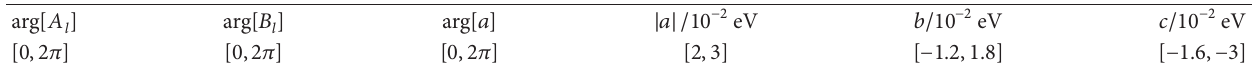
Figure 1: Predictions for mixing angles ( 𝜃 13 , 𝜃 12 , and 𝜃 23 ), Dirac CP violating phase 𝛿 , mass ratios ( 𝑚 1 /𝑚 2 , 𝑚 2 /𝑚 3 ), the mass of the lightest neutrino 𝑚 1 , sum of masses of neutrinos ∑𝑚 𝑖 , and the effective mass of neutrinoless double-beta decay 𝑚 𝑒𝑒 . Here the unit of angles is degree. Table 1: Parameter ranges of lepton mass matrices at 3𝜎